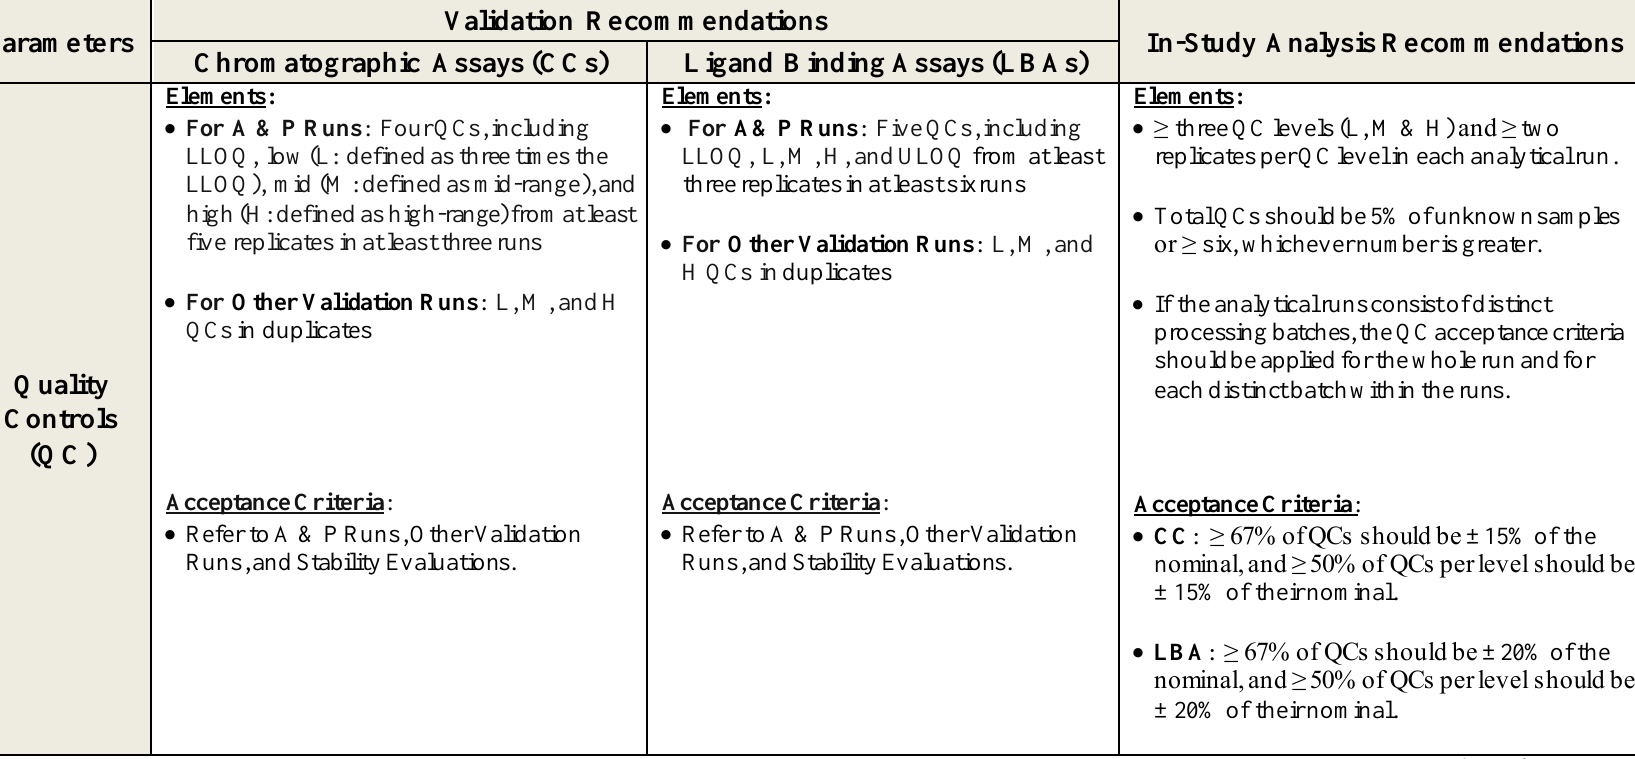
Table 1 continued. Recommendations and Acceptance Criteria for Bioanalytical Method Validation and In-Study